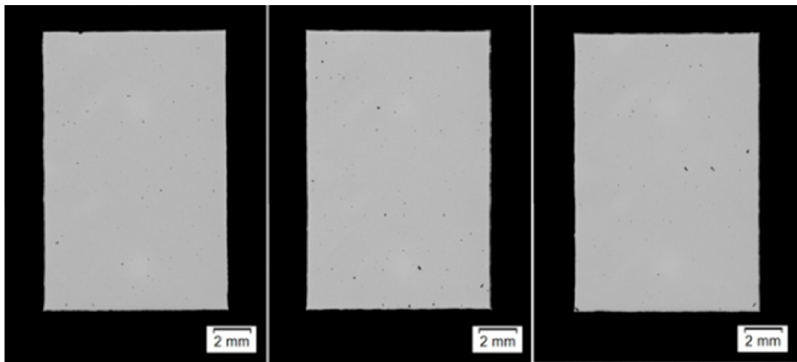
Figure 17. Cross sections of three similarily build up density cubes.